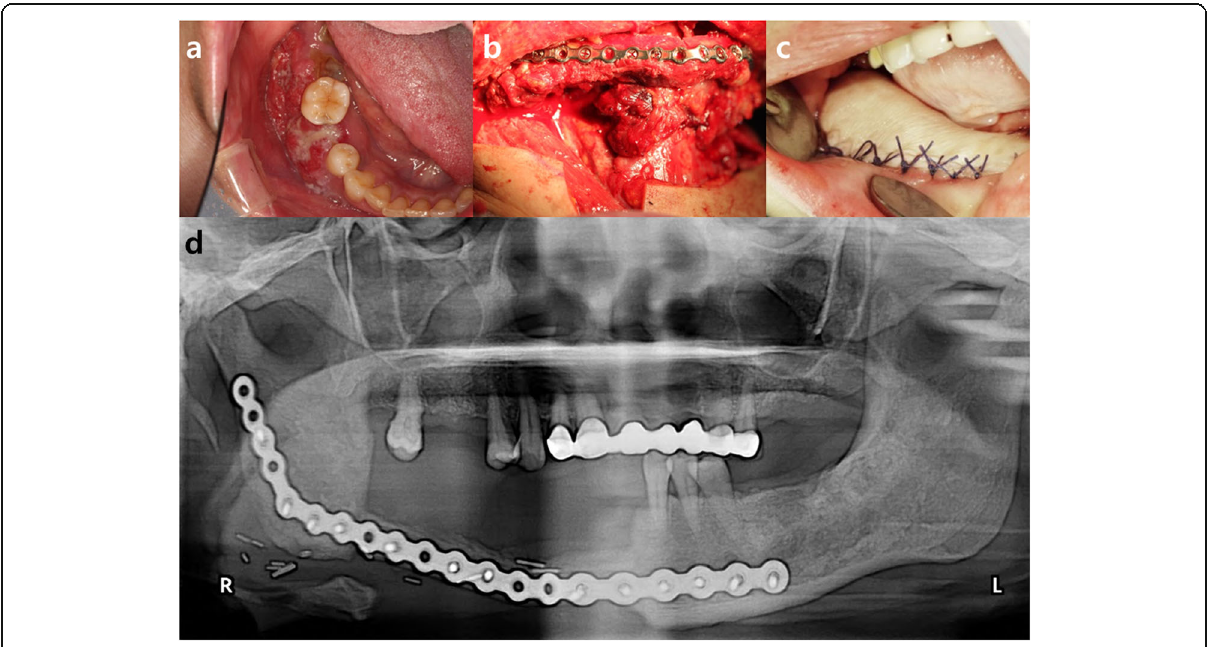
Fig. 3 a The patient was diagnosed with squamous cell carcinoma in the right mandible. b , c The patient underwent right hemi- mandibulectomy, fibula-free flap reconstruction, and split-thickness skin graft with thigh. d Postoperative panoramic view showing the reconstruction with fibula-free flap and split-thickness skin graft after the right hemi-mandibulectomy